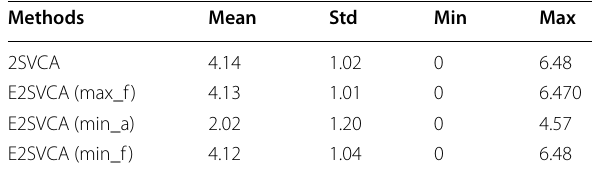
Table 5 Summary statistics of accessibility scores (per